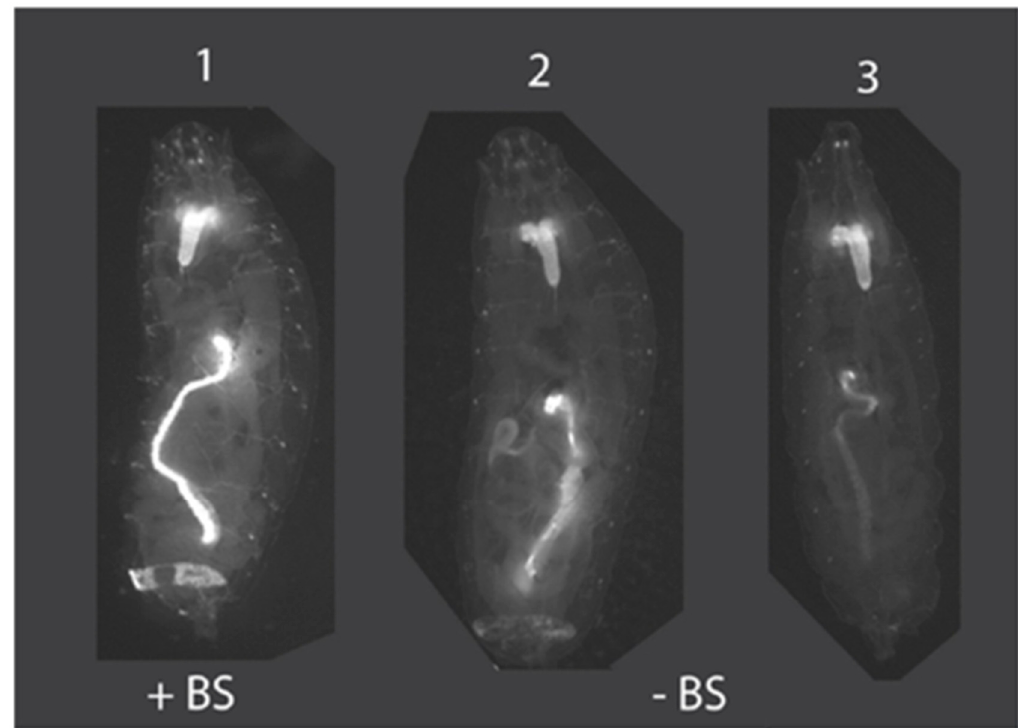
Figure 4. Insulation of position effects by su(Hw)BS. Animal #1 is an example of Drosophila trans- formed with pBac [3XP3-TagYFP, hr5-ie1-BlasR, su(Hw)BS] attP-ZFN-T, where the su(Hw)BS insulator (“+BS”) prevents position effects and TagYFP is strongly expressed in the central nervous system, eye primordium, midgut and anal pad of third instar larvae. This strong expression pattern with no variability was observed for all eight Drosophila transformant lines. In contrast, animals #2 and 3 are Drosophila transformed with the unbuffered construct pBac [3XP3-TagYFP, hr5-ie1-BlasR] attP-ZFN-T that lacks the su(Hw)BS insulator (“ − BS”) and that shows TagYFP expression in the brain in all third instar larval transformants but variable expression of TagYFP in the gut and anal pad, with expression levels differing between different transformant lines due to position effects.